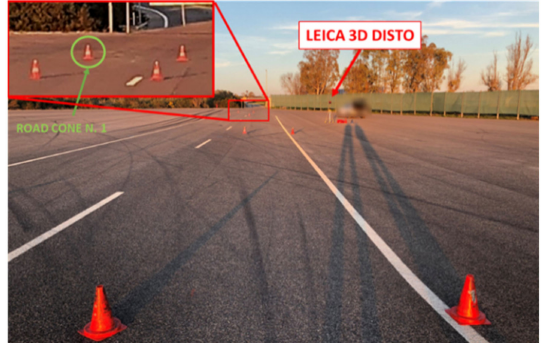
Figure 20. Arrangement of road cones on the staked-out points related to vehicle test ruled by the ISO 3888-1 standard and position of the Leica 3D Disto sensor used to measure relative distances.